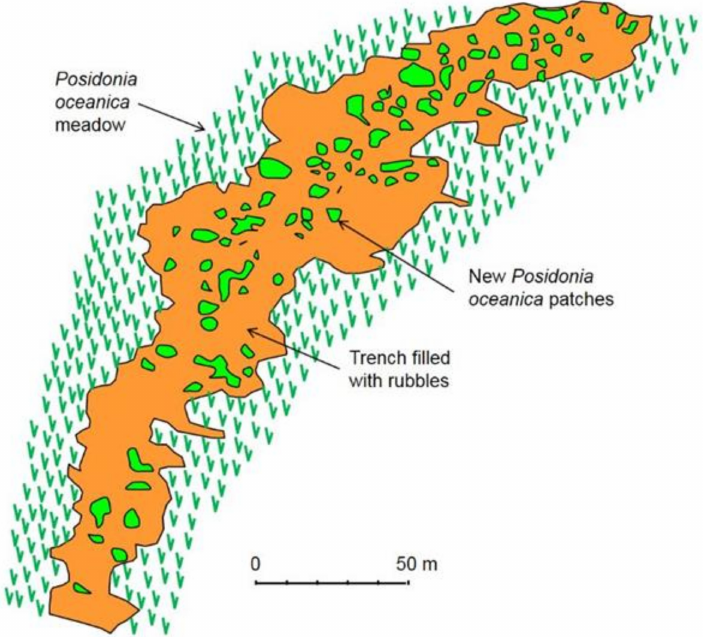
Figure 8. A trench dredged to set up a gas pipeline, then filled with rubbles in 2009, off the harbor at Ischia (Italy). Ten years later, 12% of the surface area of the trench had been spontaneously recolonized by Posidonia oceanica . From Cotugno et al. [161], redrawn and